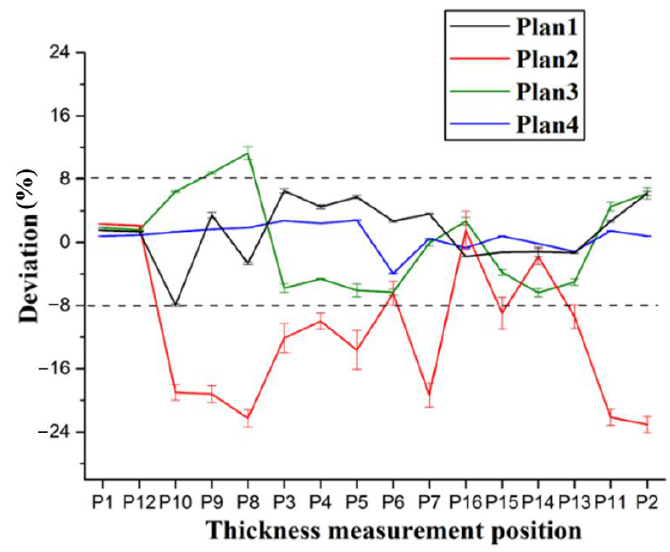
Figure 8. Influence of different filling forms on thickness.